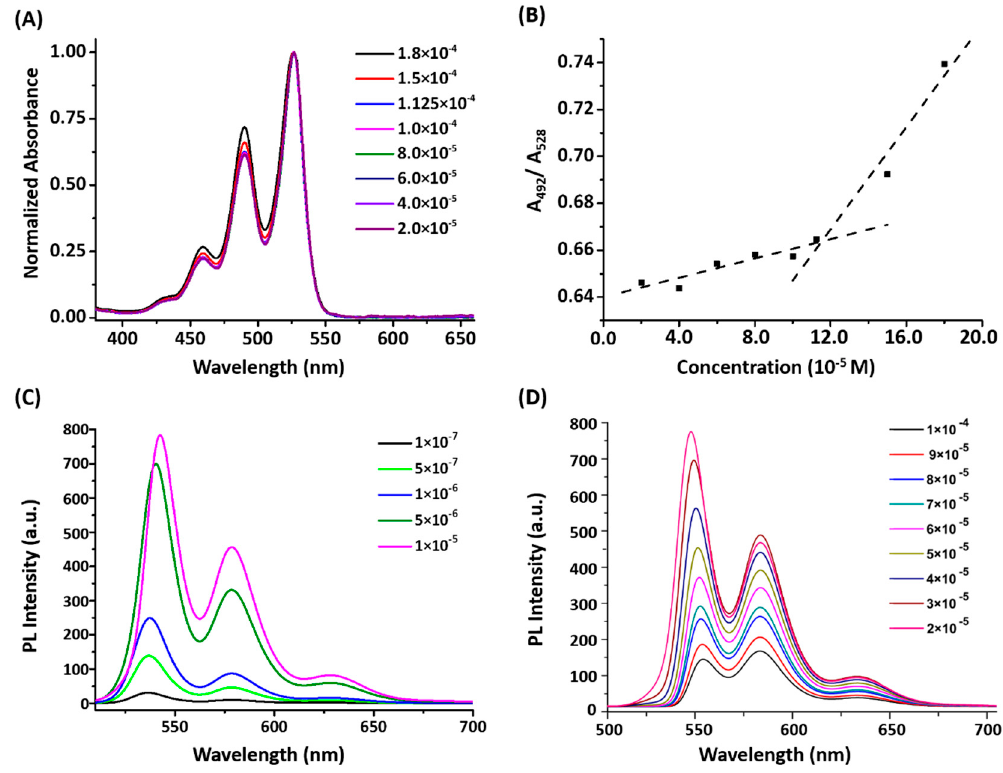
Figure 4. ( A ) Concentration-dependent UV / Vis absorption spectra of BPOSS-PDI-OH in CHCl 3 at concentrations from 2.0 × 10 − 5 M to 1.8 × 10 − 4 M. ( B ) Plot of the ratio of absorbance ( A 492 / A 528 ) versus concentration. The two linear dashed trend lines are included to illustrate the transition. ( C , D ) Photoluminescence spectra of BPOSS-PDI-OH in CHCl 3 at concentrations from 1 × 10 − 7 M to 1 × 10 − 5 M ( C ), and from 2 × 10 − 5 M to 1 × 10 − 4 M ( D ).